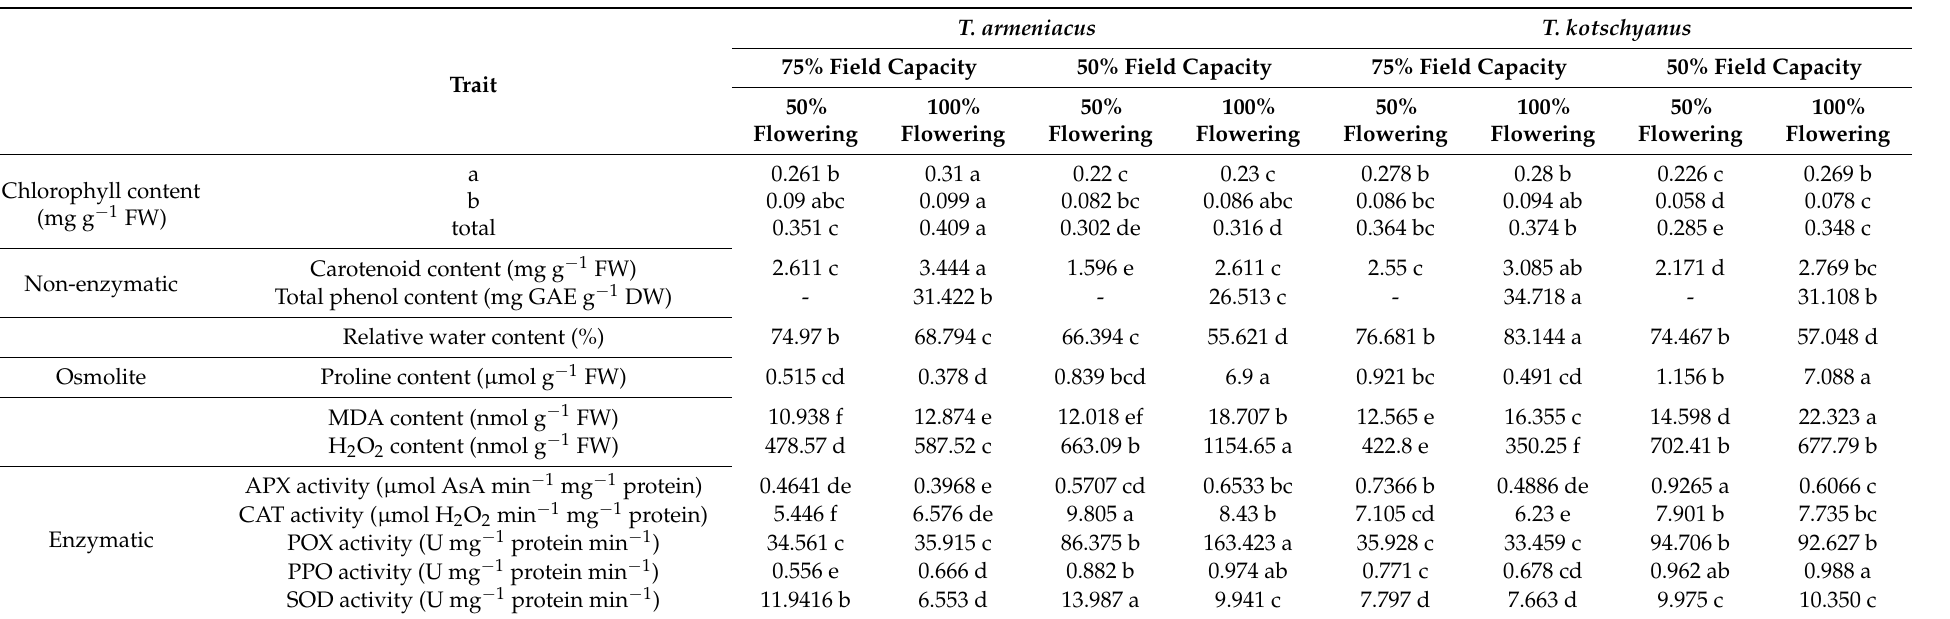
Table 6. The effect of irrigation regime on the content of chlorophyll, carotenoids, total phenolics, proline, malondialdehyde (MDA), and hydrogen peroxide (H 2 O 2 ), as well as on relative water content and five antioxidant enzymes activity of two Thymus species at two developmental stages (50 and 100% blooming). Within each column, different letters indicate significant differences ( n = 3). APX, ascorbate peroxidase; AsA, ascorbic acid; CAT, catalase; dw, dry weight; fw, fresh weight;